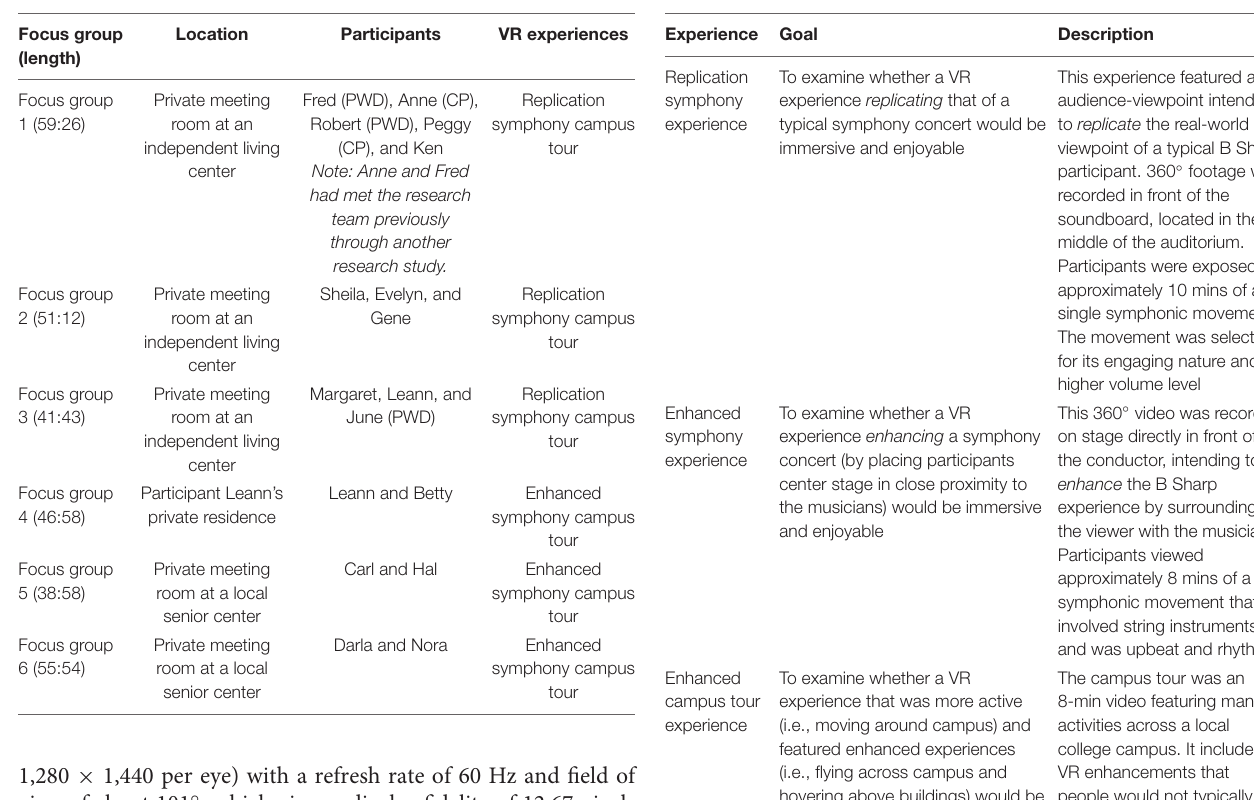
TABLE 1 | Focus group participant information. TABLE 2 | Virtual reality experience